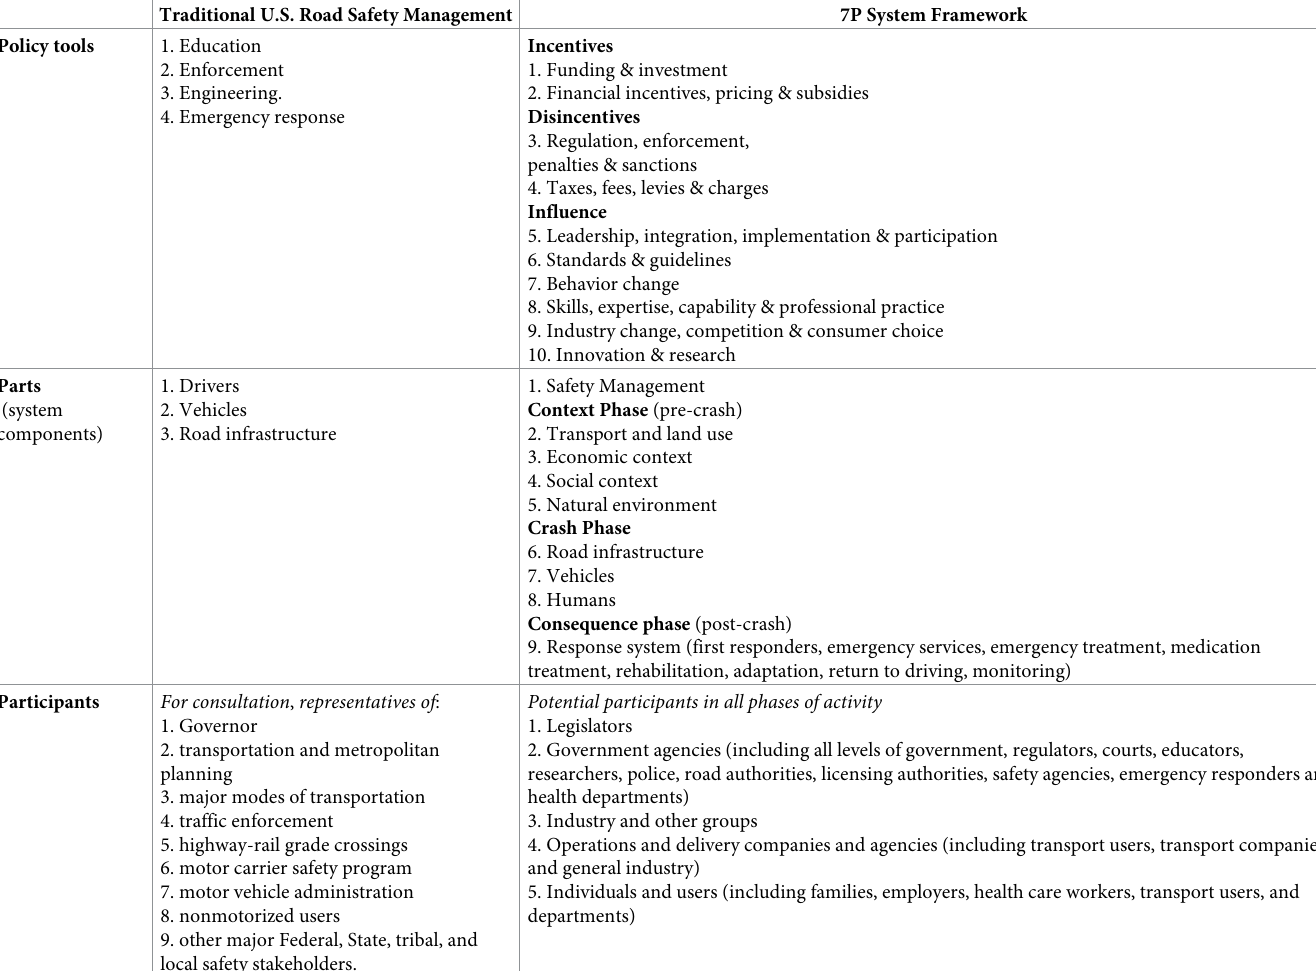
Table 1. Policy tools, parts and participants in traditional road safety management compared with the P7 System